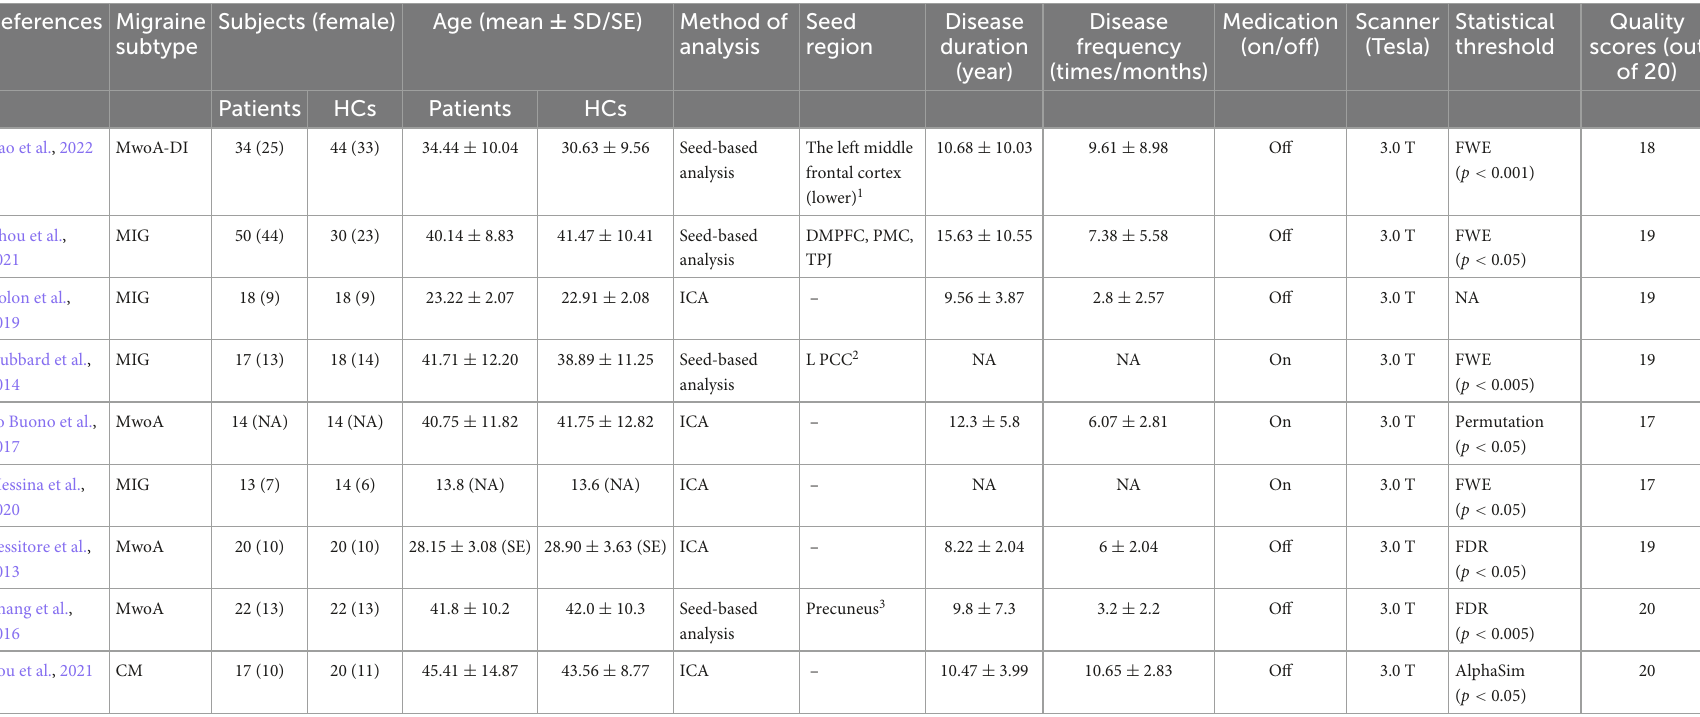
TABLE 1 Characteristics of resting-state functional magnetic resonance imaging (rs-fMRI) studies included in the